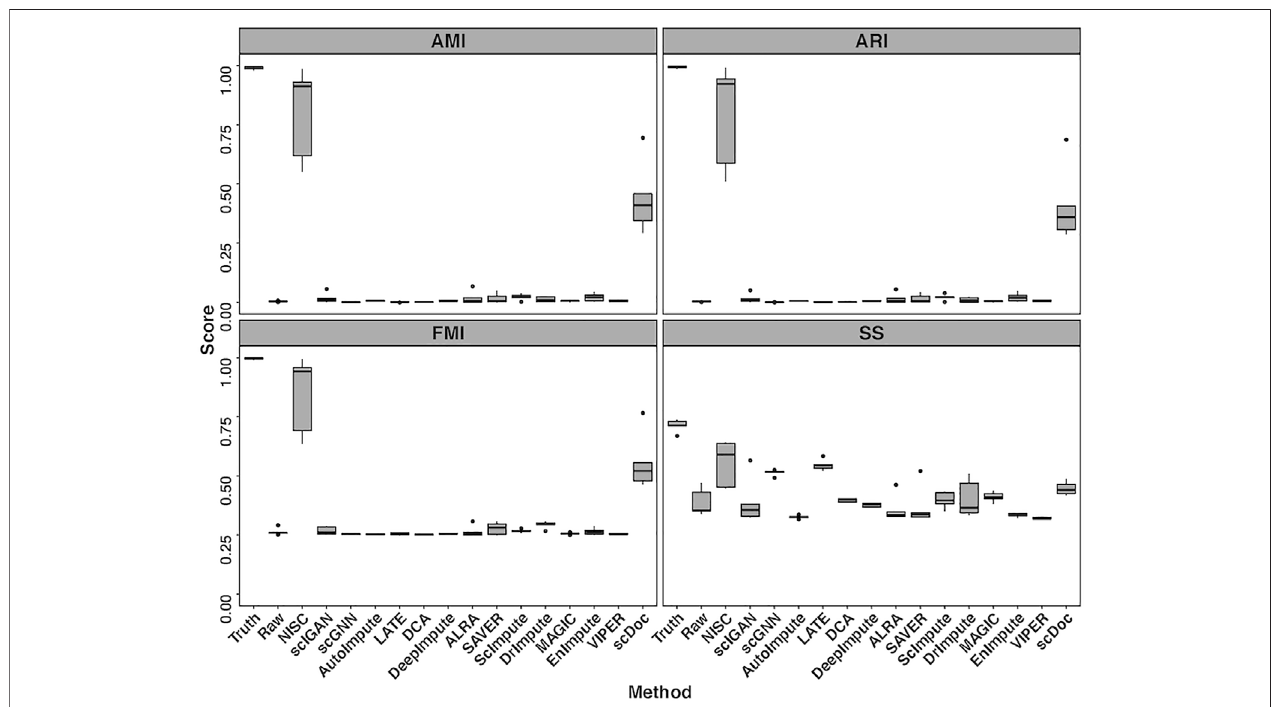
FIGURE 3 | Boxplots of four evaluation measures, including Adjusted Mutual Information (AMI), Adjusted Rand Index (ARI), Fowlkes-Mallows Index (FMI), and Silhouette Score (SS), are calculated for comparing NISC and other imputation methods. Each dataset contains 800 genes and 1,000 cells in 4 cell types, with 90% sparsity, and is replicated 10 times. Detailed information about these measurements can be found in the supplementary materials.